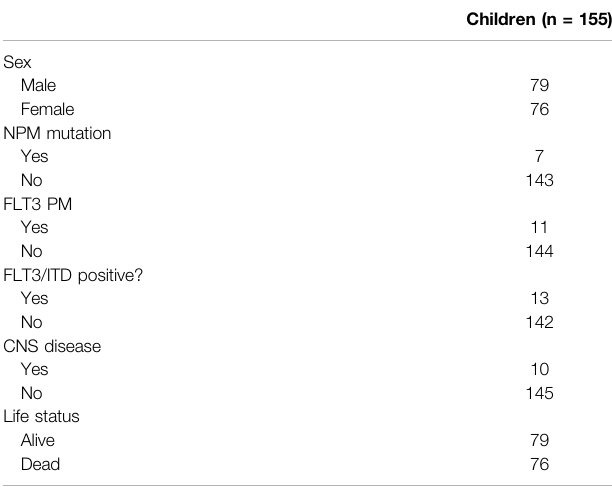
TABLE 1| Clinical characteristics ofpatientsfrom theTARGET database included in the validation